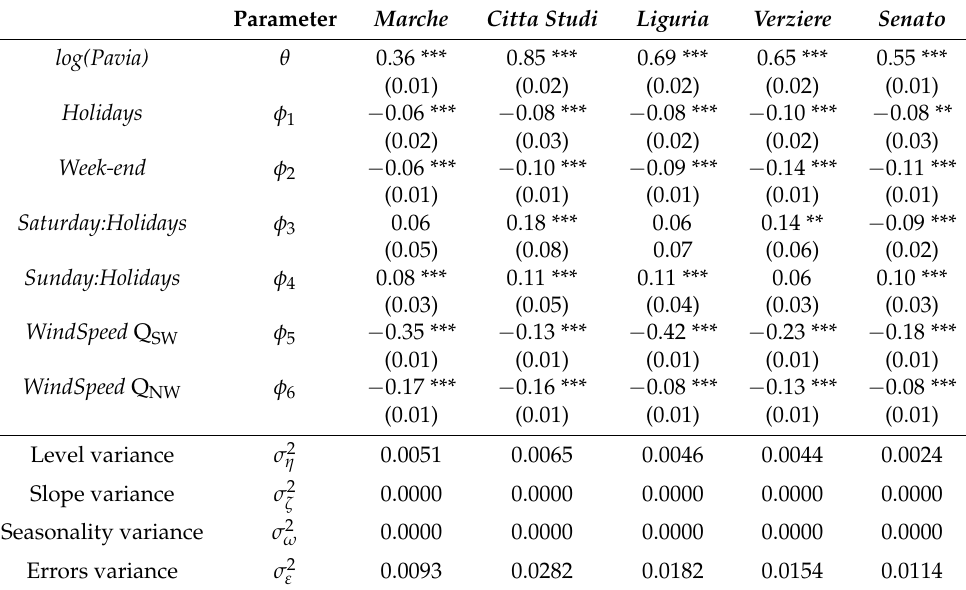
Table 5. ML estimates of BSM parameters and variances for NO 2